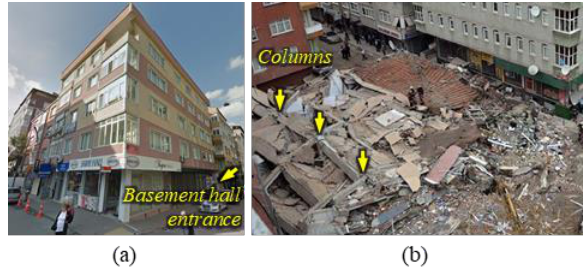
Figure 5. Investigated building: (a) before collapse and, (b) after collapse (Modified from Google, 2022; IHA, 2016)